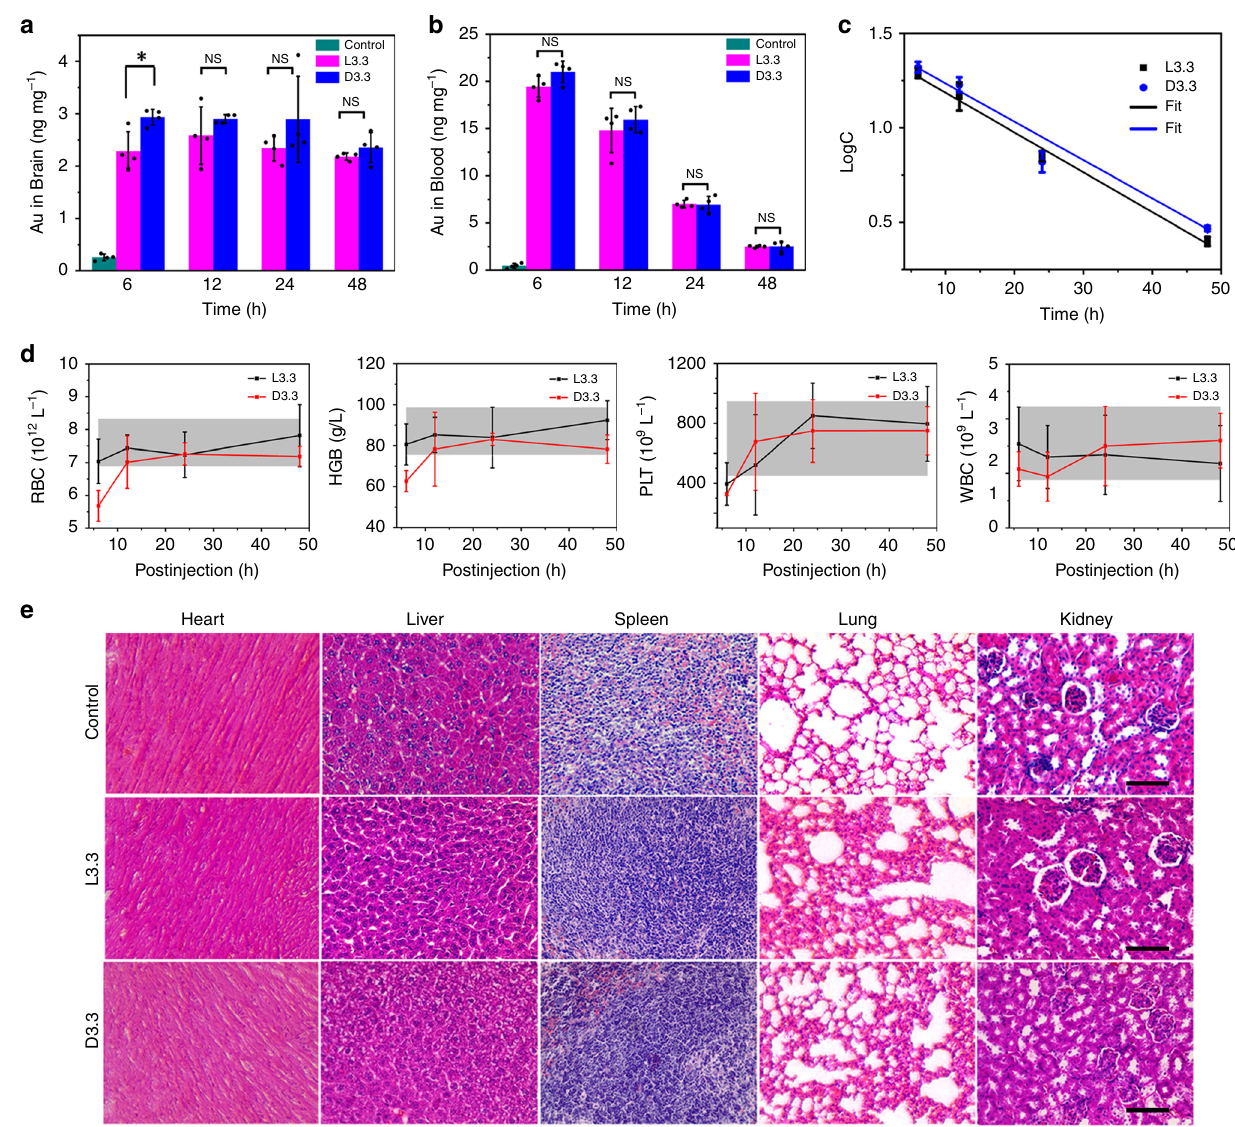
Fig. 4 Biodistribution and toxicity evaluation of L3.3 and D3.3 in vivo. a , b Biodistribution of L3.3 and D3.3 in the brain ( a ) and blood ( b ) at 6 h, 12 h, 24 h, and 48 h post-injection. Error bars indicate the s.d. ( n = 4 mice per group). * P < 0.05; NS not signi fi cant; two-sided Student ’ s t test. For detailed statistical analysis see Supplementary Tables 6 and 7. c Elimination kinetics of L3.3 and D3.3 in plasma. The concentration-time pro fi les of L3.3 and D3.3 in plasma ( b ) fi t the fi rst-order elimination. The fi tting equation for L3.3 and D3.3 groups is y = 1.396 − 0.0211 x ( r 2 = 0.992) and y = 1.43758 − 0.0203 x ( r 2 = 0.989), respectively. d Hematological parameters, including red blood cells (RBC), hemoglobin (HGB), platelets (PLT), and white blood cells (WBC) of the KM mice after treatment with L3.3 or D3.3 for 6 h, 12 h, 24 h, and 48 h. The shadow regions represent the normal range of control groups. Error bars indicate the s.d. ( n = 3 mice per group). For detailed statistical analysis see Supplementary Table 6. e H&E staining assays of the heart, liver, spleen, lung, and kidney from all experimental groups ( n = 2 mice per group). Scale bars, 100 μ m. Source data are provided as a Source Data fi